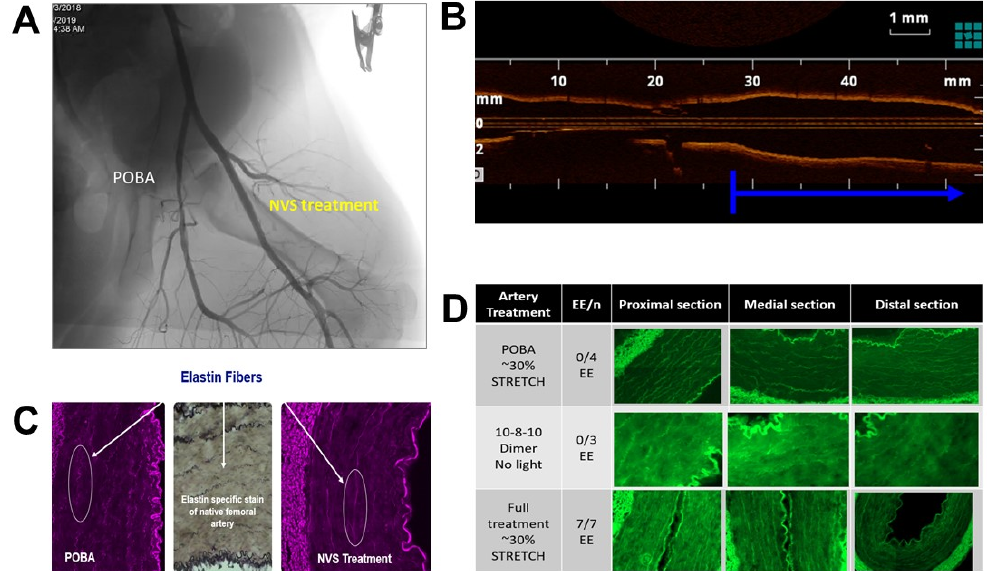
Figure 8. NVS treatment effect in healthy swine: ( A ) Angiographic image of the scaffolded or NVS- and plain old balloon angioplasty (POBA)-treated arteries. ( B ) Longitudinal intravascular optical coherence tomography image of the NVS-treated artery (blue arrow) in comparison to the adjacent non-inflated and treated part of the same artery. ( C ) Elastin fibers after POBA and NVS treatment (white arrows pointig to areas in white oblongs). ( D ) Histological cross-sections from POBA and only 10-8-10 Dimer-treated vessels in comparison to the section from NVS-treated vessels.